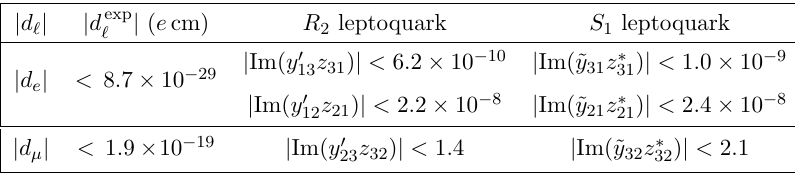
Table 4 . Bounds on R 2 and S 1 leptoquark couplings from the electric dipole moments of leptons, at 90% C.L. (95% C.L.) for the electron (muon), for M LQ = 1 TeV. For larger leptoquark masses, the numbers increase approximately as M 2 LQ